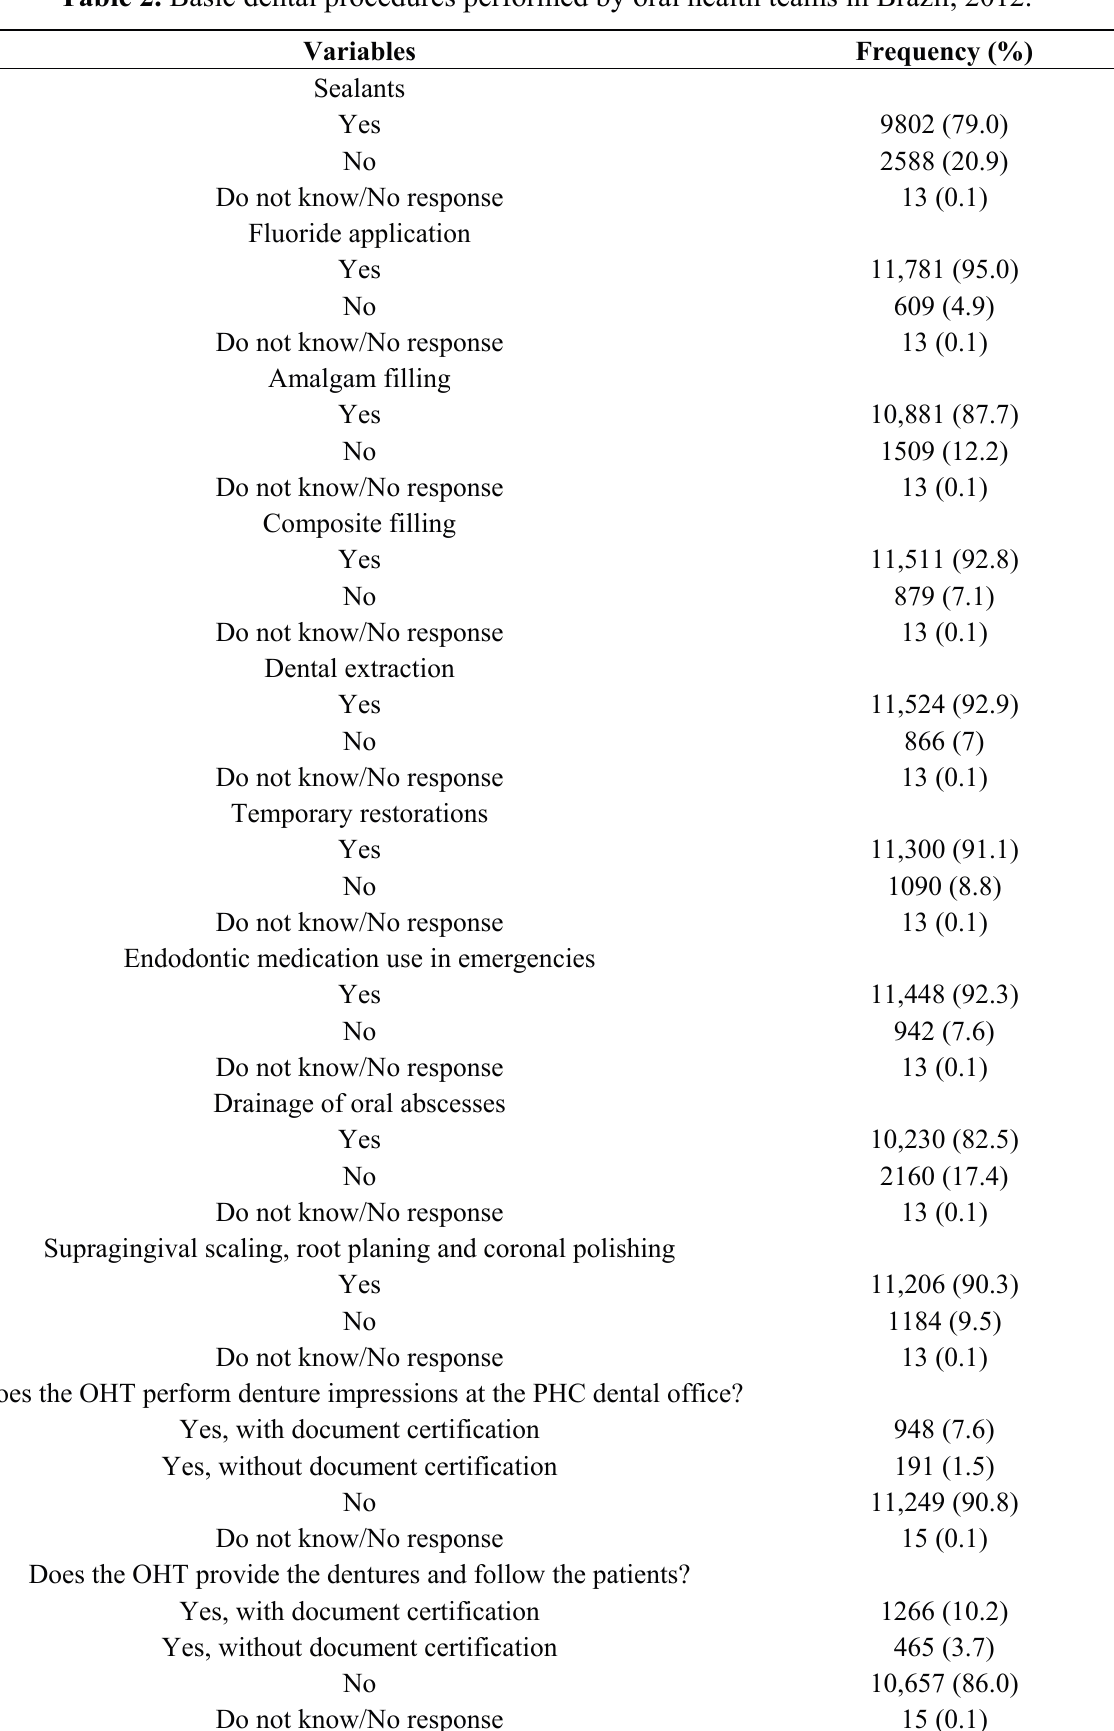
Table 2. Basic dental procedures performed by oral health teams in Brazil,